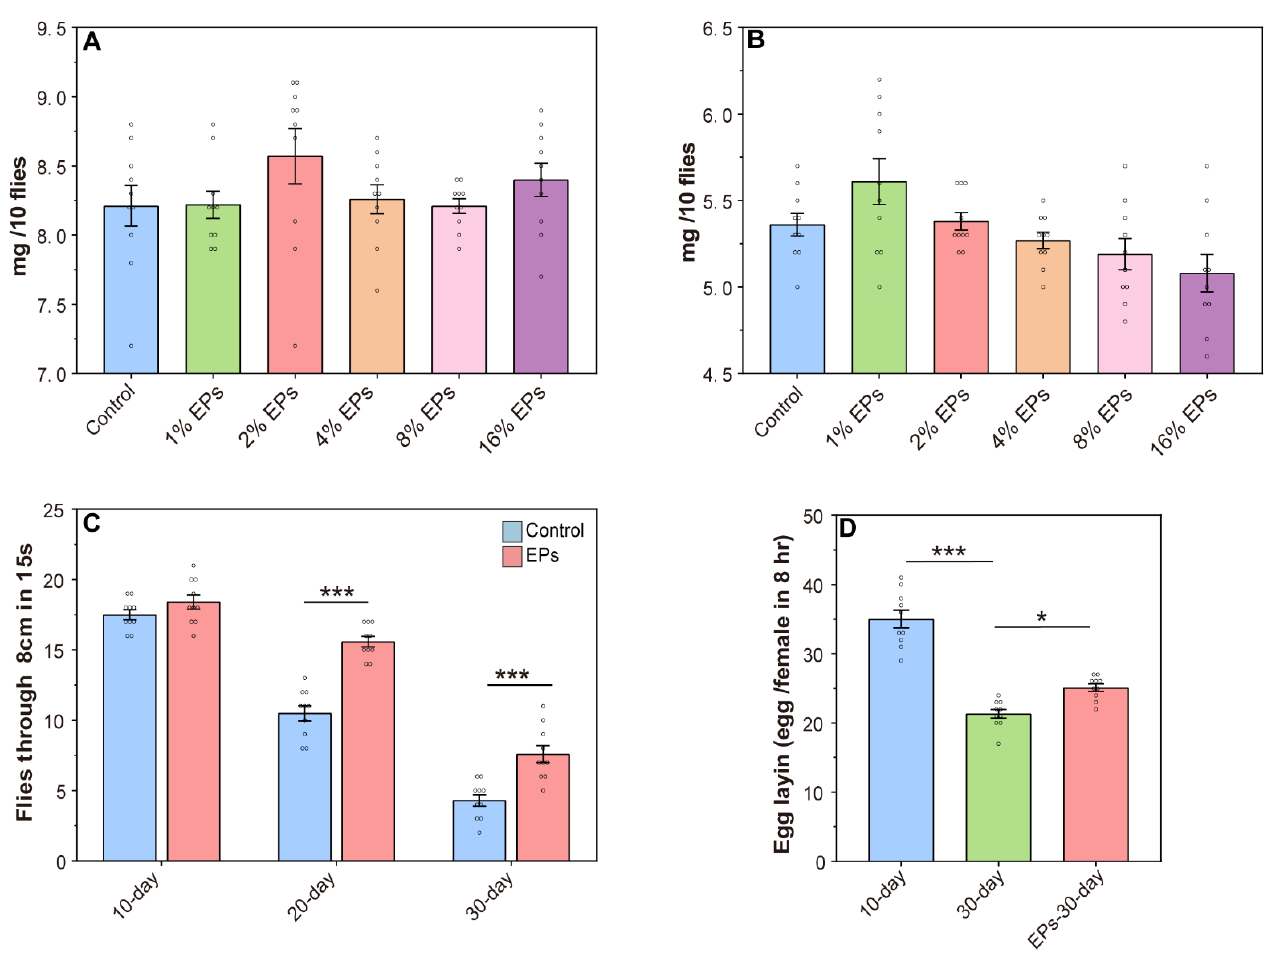
Figure 3. Effect of EPs on the behavior of aged flies. ( A ) Effect of EP (1 – 16%) supplementation on the weights of female flies. ( B ) Effect of EP (1 – 16%) supplementation on the weights of male flies . ( C ) Effect of EPs on the locomotor activity of old flies ( D ) Effect of EPs on the fecundity of old flies . * p < 0.05 ， *** p < 0.001.